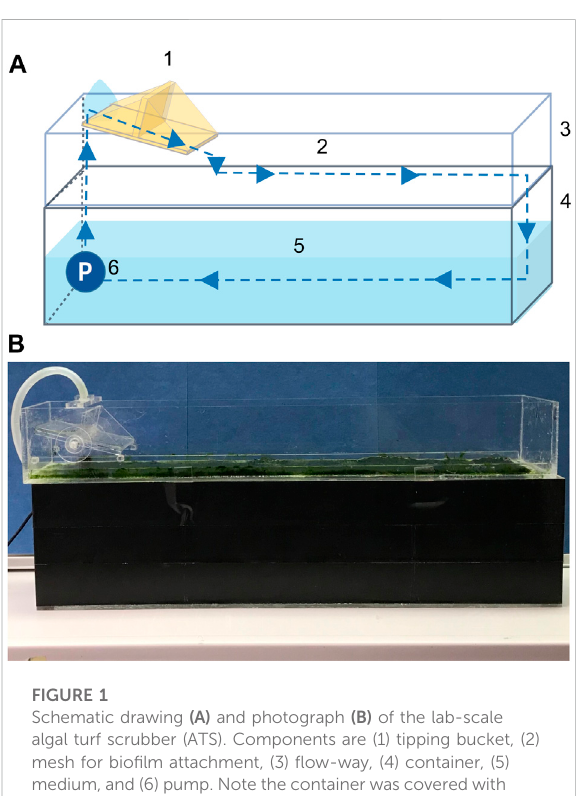
FIGURE 1 Schematic drawing (A) and photograph (B) of the lab-scale algal turf scrubber (ATS). Components are (1) tipping bucket, (2) mesh for bio fi lm attachment, (3) fl ow-way, (4) container, (5) medium, and (6) pump. Note the container was covered with opaque material to limit the light in fl